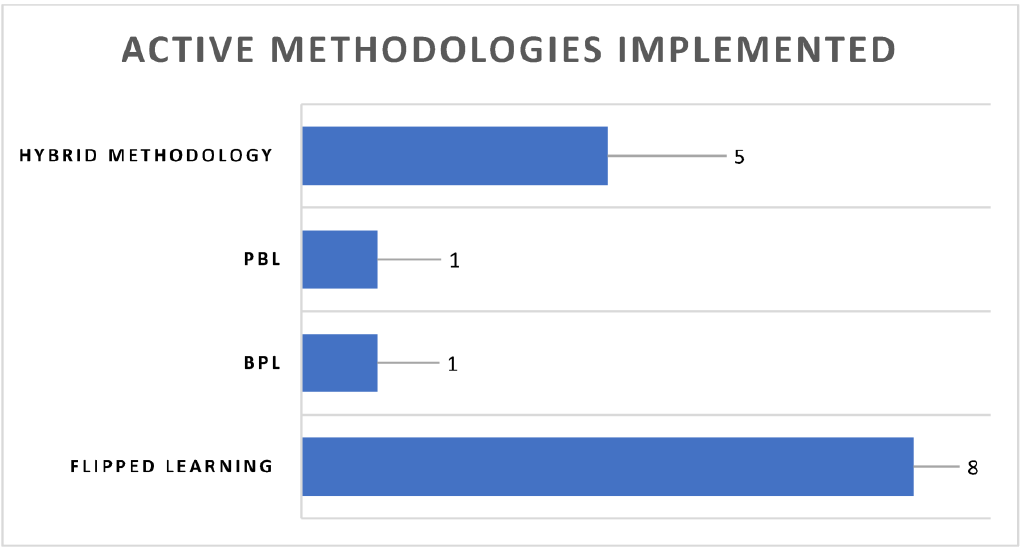
Figure 4. Active